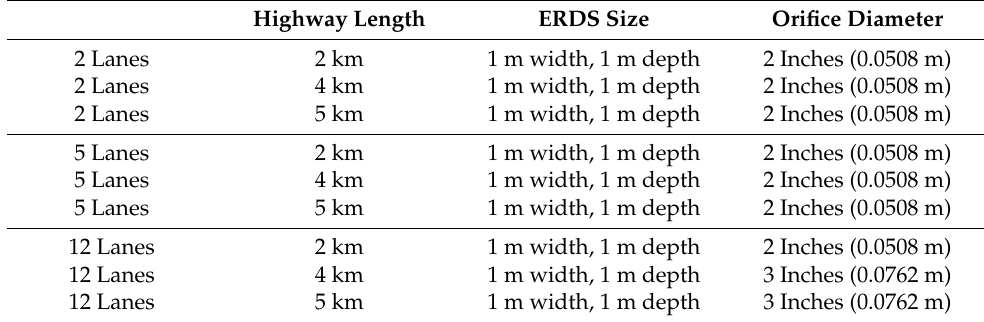
Table 2. Summary of ERDS size and orifice diameter for each scenario.